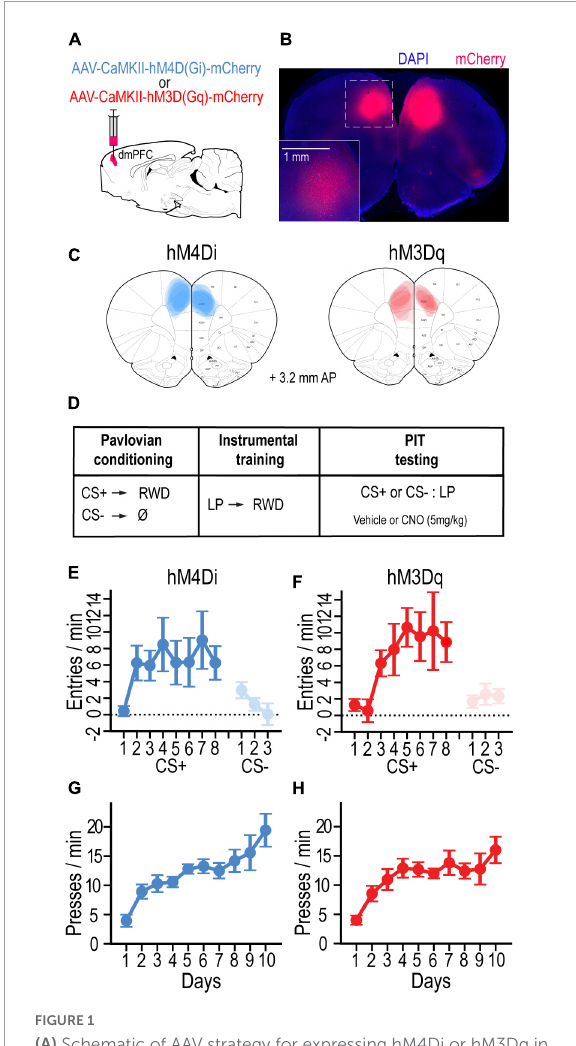
FIGURE1 (A) Schematic of AAV strategy for expressing hM4Di or hM3Dq in dmPFC. (B) Coronal section showing representative mCherry-labeled DREADD expression. (C) Localization of DREADD expression for rats in hM4Di and hM3Dq groups (adapted from Paxinos and Watson, 2014). (D) Schematic of experimental design. (E,F) Mean cue-evoked food-port entry rate (entries/min; CS – Pre; ± SEM) during Pavlovian conditioning sessions with the CS+ and CS– for hM4Di (E) and hm3Dq (F) groups. (G,H) Mean rate of lever pressing (presses/min; ± SEM) during instrumental conditioning sessions for hM4Di (G) and hm3Dq (H)